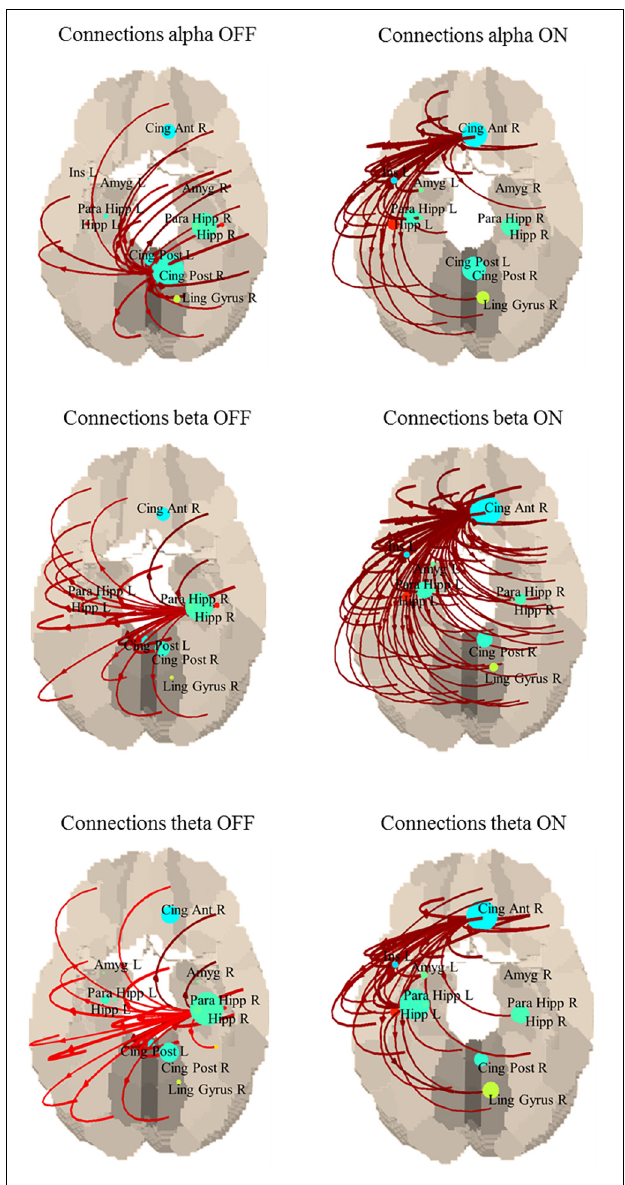
FIGURE 2 | Connections between each ROI in OFF (left) and ON (right). Only the strongest 30% connections are shown. Alpha band: the main driver of connections is the posterior cingulate in the OFF state and the anterior cingulate in the ON state. Beta band: the main driver of connections is the right hippocampus in the OFF state and the anterior cingulate in the ON state. Theta band: the main driver of connections is the right hippocampus in the OFF state and the anterior cingulate in the ON